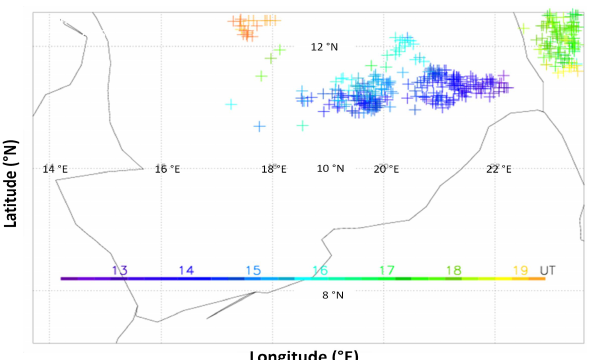
Fig. 3 Fig. 3. MSG pixels with brightness temperature difference (BTD) higher than 3K between the 6.2µm channel and the 10.8µm chan- nel in Southern Chad from 12:30UT to 19:30UT on 4 August 2006. The time resolution of MSG data is 15